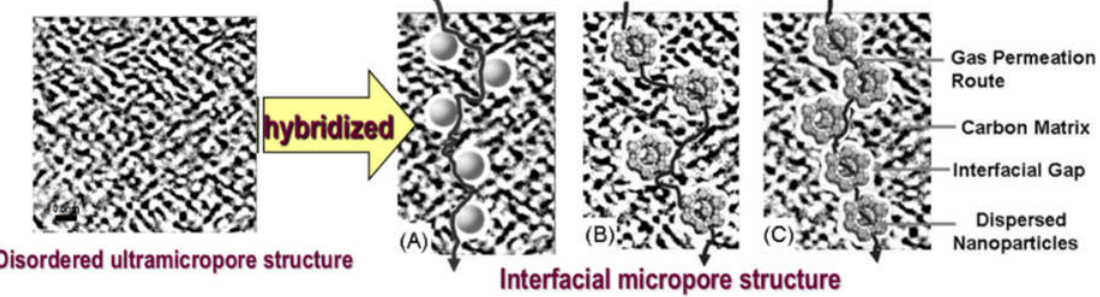
Figure 23. The structure and gas diffusion routes model of inorganic nanoparticles/C hybrid membranes: well-dispersed nanoparticles without inner channels/C ( A ); homogeneously dispersed porous nanoparticles/C ( B ); and porous nanoparticles/C dispersed nanoparticles forming a continuous phase/C hybrid membrane ( C